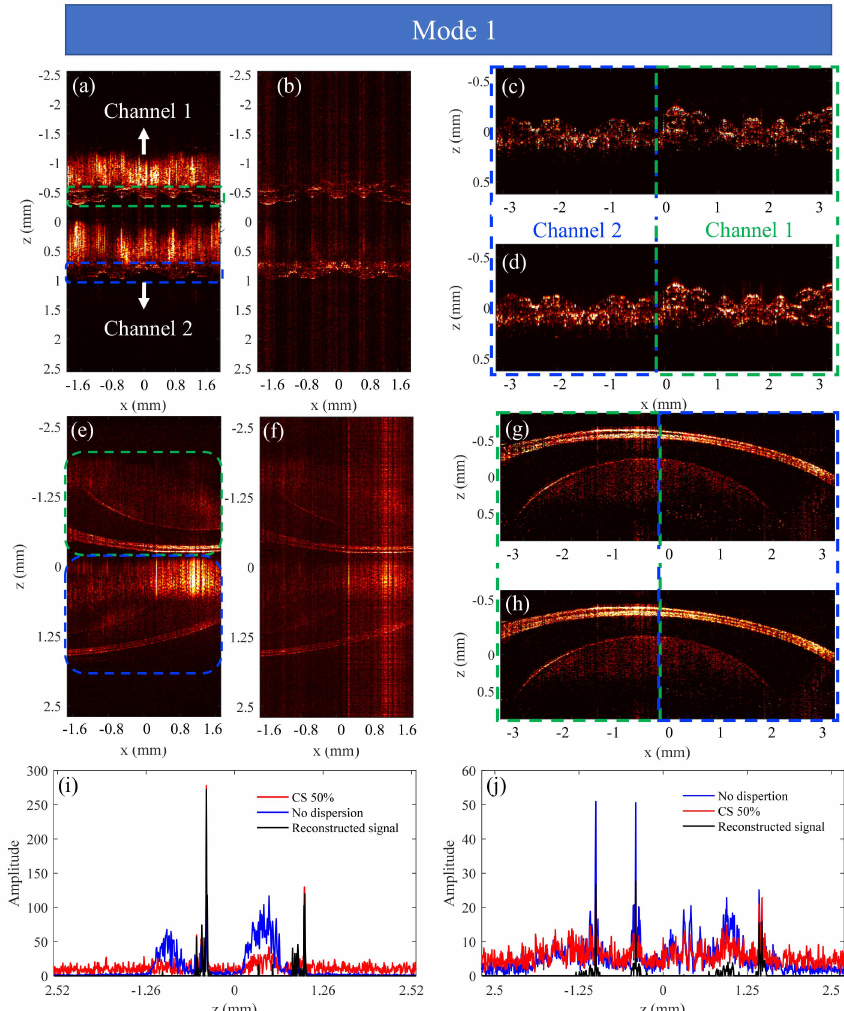
Figure 6. Experiment results of a fish fin and a fish eye. The results in ( a , e ) are obtained using complete spectral data, and the results in ( b , f ) are obtained using 50% spectral data. Panels ( c ) (50% data) and ( d ) (100% data) show images of a fish fin that are stitched together by the results of the two channels; Panels ( g ) (50% data) and ( h ) (100% data) show images of a fish eye that are stitched together by the results of the two channels; ( i , j ) show the data processing steps for the fish fin and fish eye,